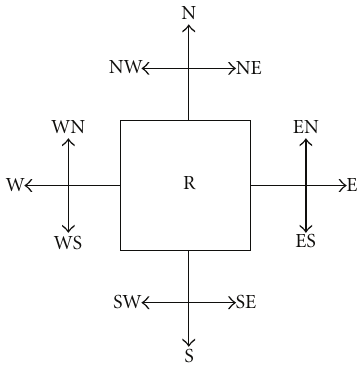
Figure 3: Routing directions. N: North, S: South, E: East, W: West, and R: Router.